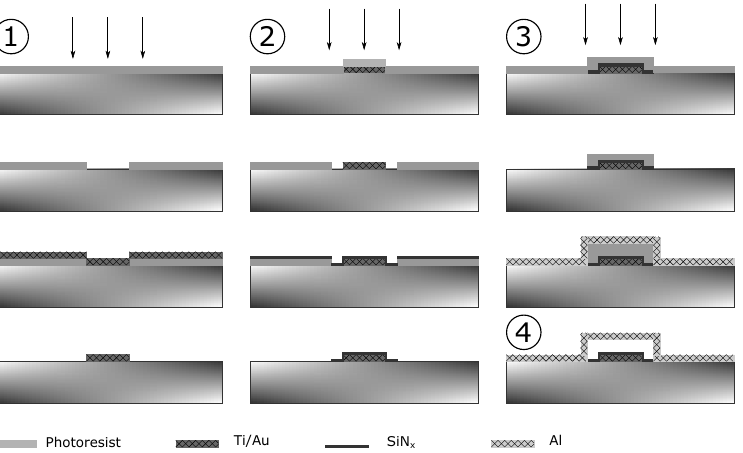
Figure 1. MOEMS forming map. Bottom electrode forming, protective dielectric layer forming, membrane forming, and release of the membrane are indicated by encircled 1, 2, 3, and 4,